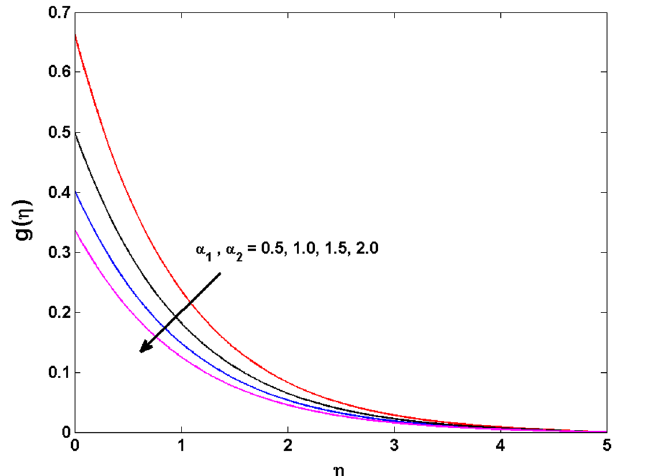
Figure 7. Variations of α 1 , α 2 to g (η)